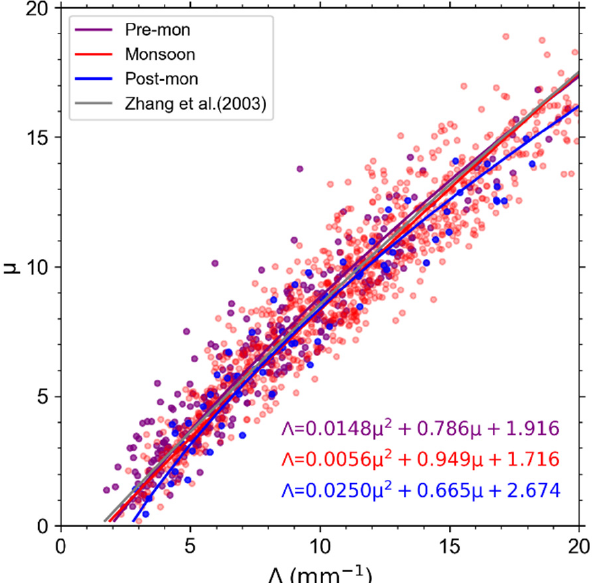
Figure 11. Scatterplots of μ versus Λ and the empirical fitting relationships for samples with rain rates > 5 mm h − 1 and drop counts > 300 during the premonsoon, monsoon and postmonsoon seasons. The colored solid lines are the fitted empirical μ – Λ relationships in different seasons, and the gray solid line represents the empirical μ – Λ relationship of Zhang et al. [38].